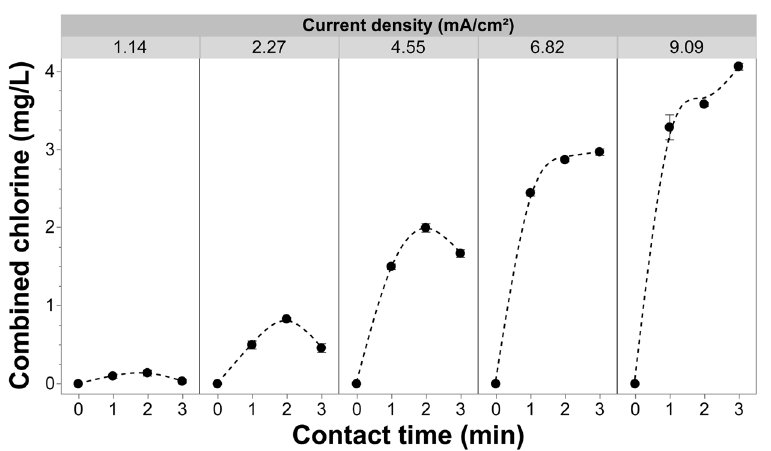
Figure 8. Effluent combined chlorine measured from the EFC as a function of current density and contact time, while maintaining the concentration of fertilizer at 0.5 g/L. All of these experiments were conducted with a chloride concentration of 20 mg/L. Error bars are ± SEM, N =